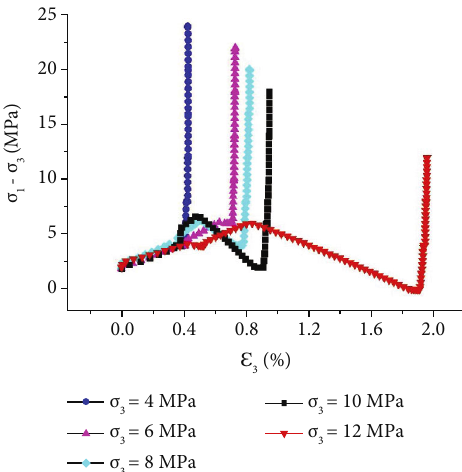
V of single-fracture specimen.